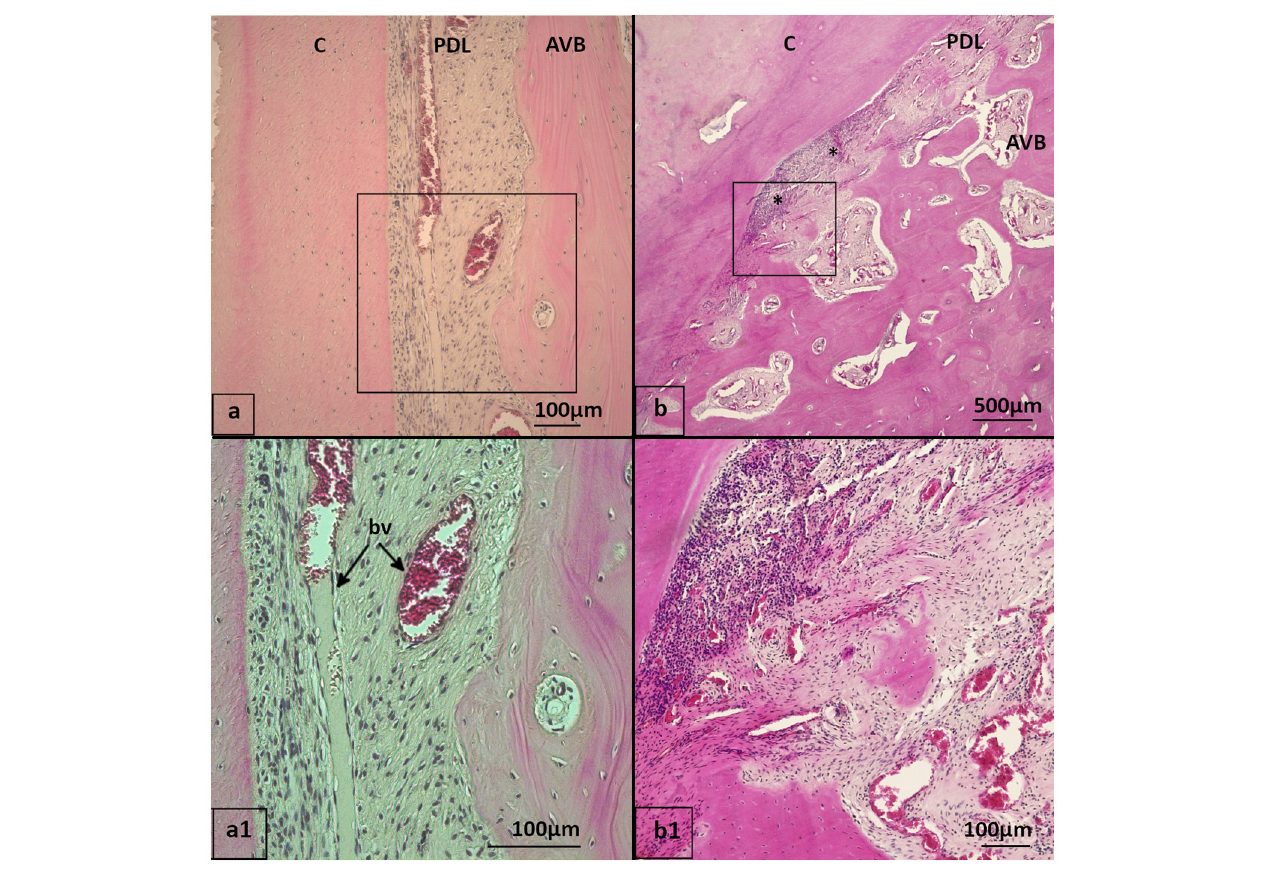
FIGURE5 Leukocyte infiltrations (LI) in PDL, HE stained (a, a1) 21-year-old Haflinger gelding of the control group, 108 buccal aspect with no LI in PDL. The tooth position showed a gingival sulcus depth of < 1mm and macroscopic gingiva alterations. No leukocyte infiltration within the PDL. Bv, blood vessels in longitudinal direction in the PDL. (b, b1) 28-year-old Warmblood mare with PPID, 409 buccal aspect with focal LI ( * ) in the PDL without periodontal pocket close to the observed area. The tooth position showed a gingival sulcus depth of 3mm and macroscopical alterations of the gingiva. PDL, Periodontal ligament; AVB, Alveolar bone; C, Cementum.